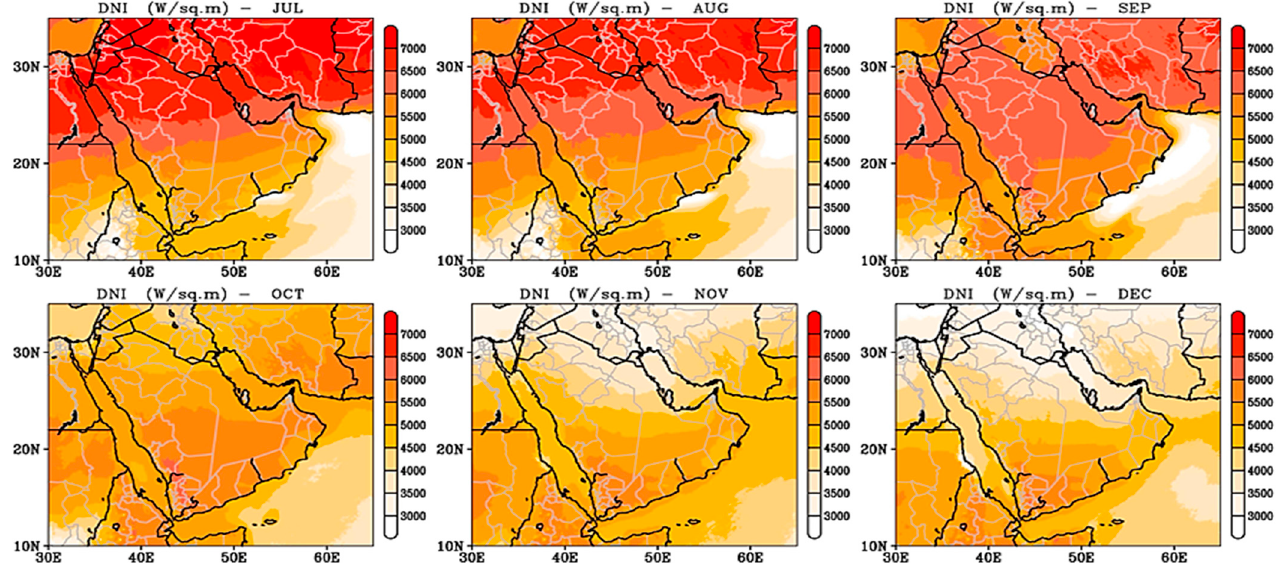
Figure 4. The monthly performance of DNI (W/m 2 ) over 37 years (1980–2017) in the GCC region. Copyright © 2021 Elsevier [55]. Table 3. Average annual dust in GCC countries and effective